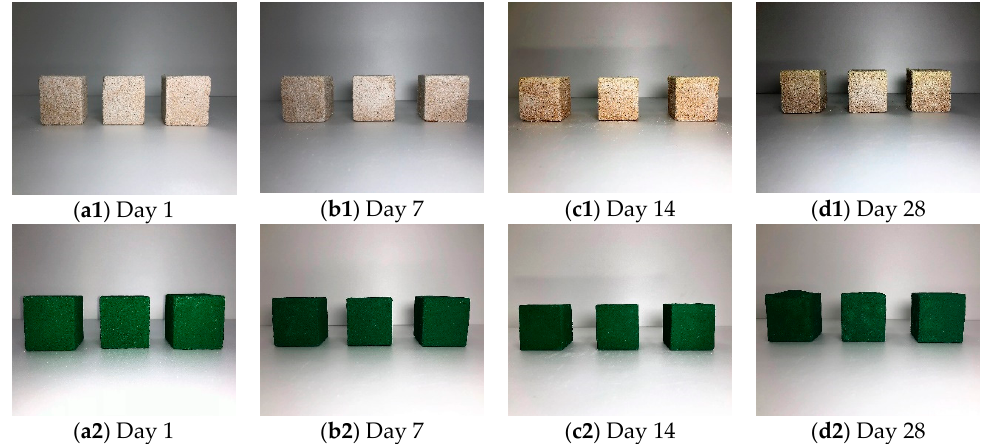
Figure 4. Specimens submerged in hydrochloric acid.